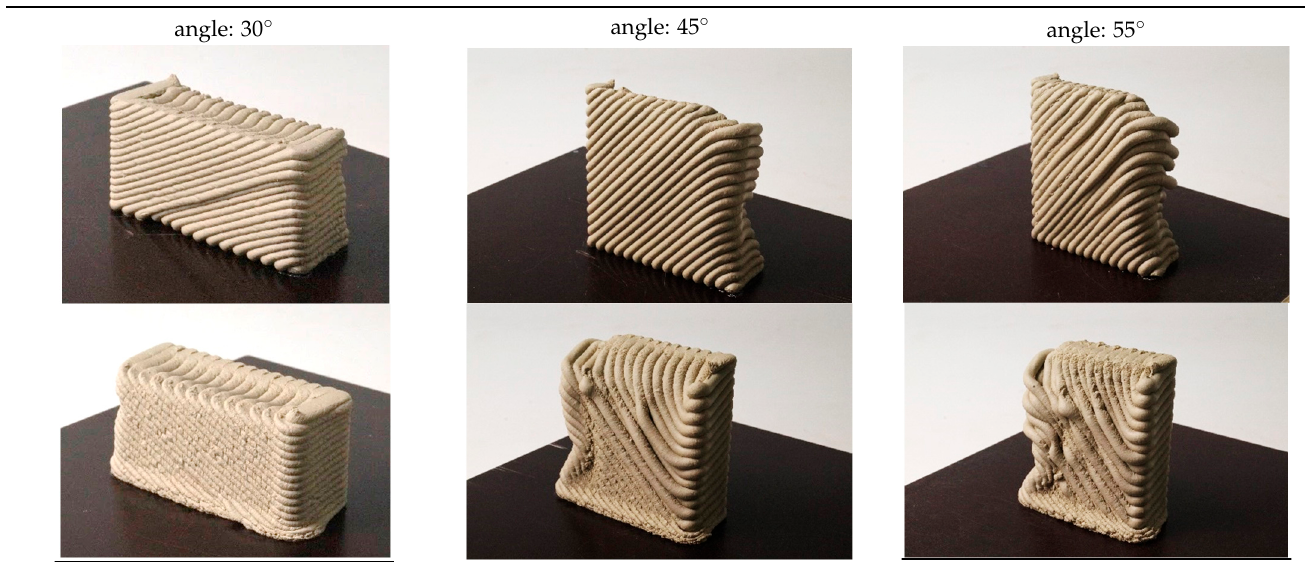
Table 9. Comparison of extrusion directions with different angles of material layering—front side (top) shows extrusion direction in each case from bottom to top, rear side (bottom) shows extrusion direction in each case from top to bottom.